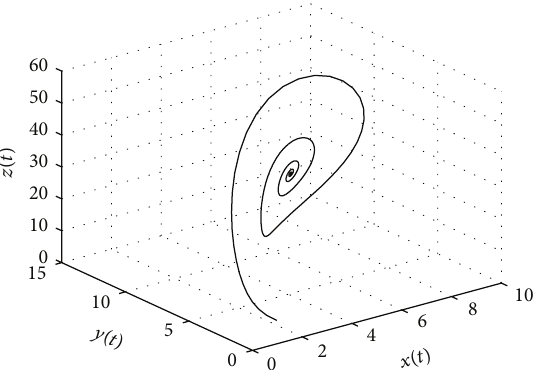
Figure 15: Periodic solution for the fractional general 𝑇 system (6) when 𝑏 1 = 16 . 6.